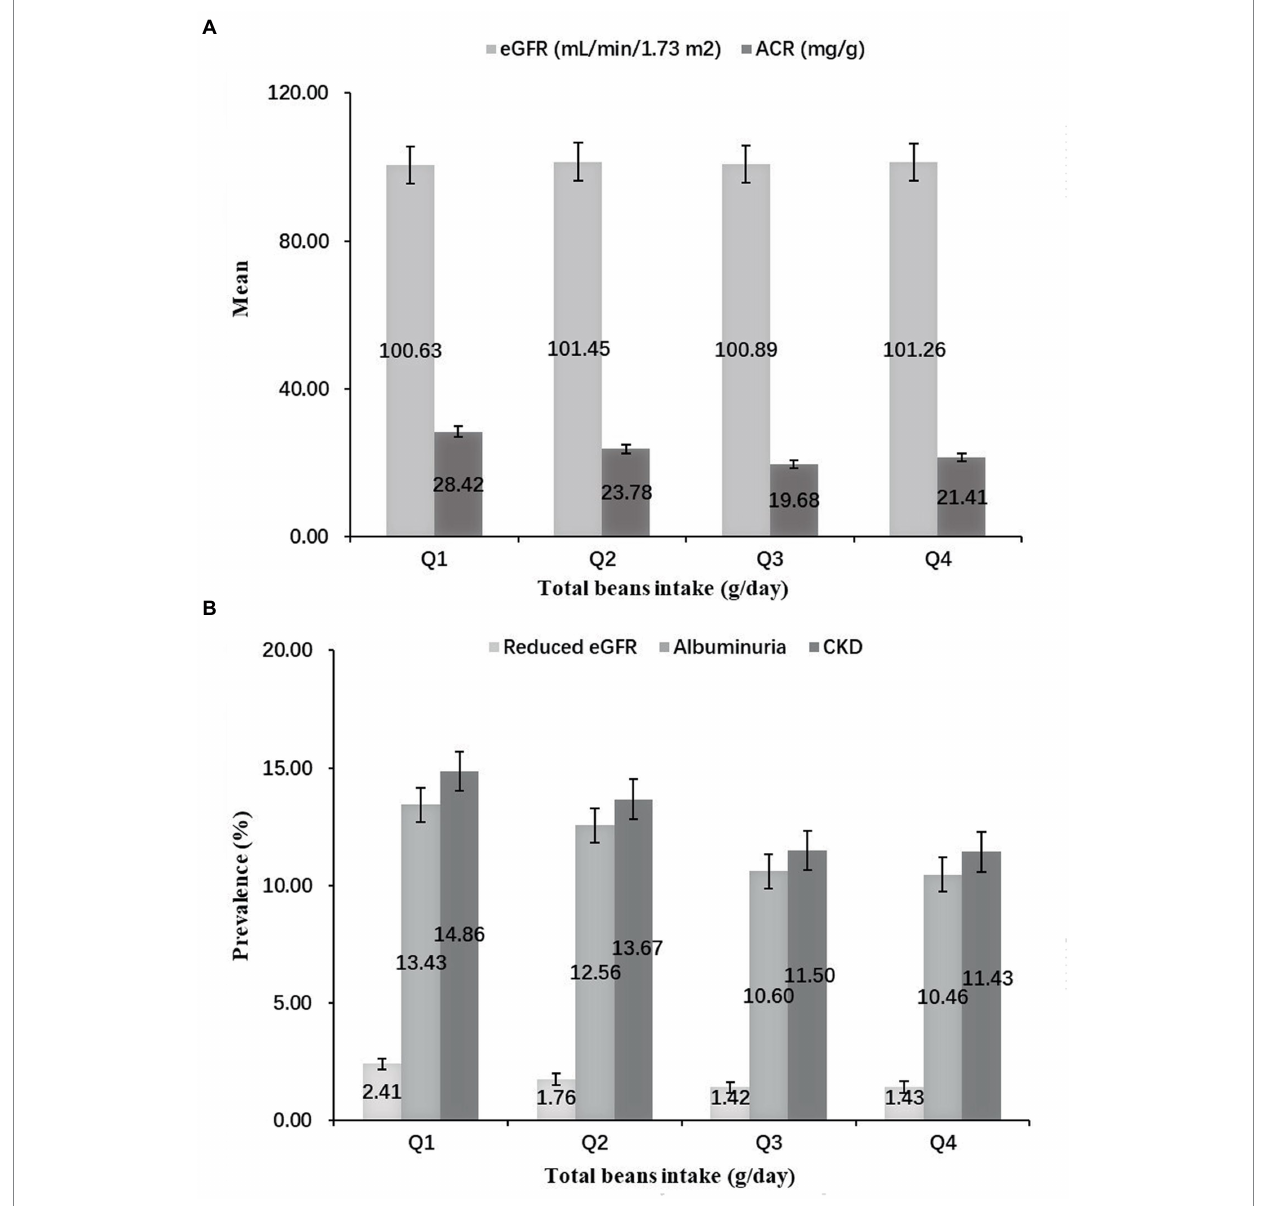
FIGURE 1 Distributions and prevalence of kidney injury indicators according to quartiles of total beans intake. (A) Distributions of kidney injury indicators according to quartiles of total beans intake. (B) Prevalence of kidney injury indicators according to quartiles of total beans